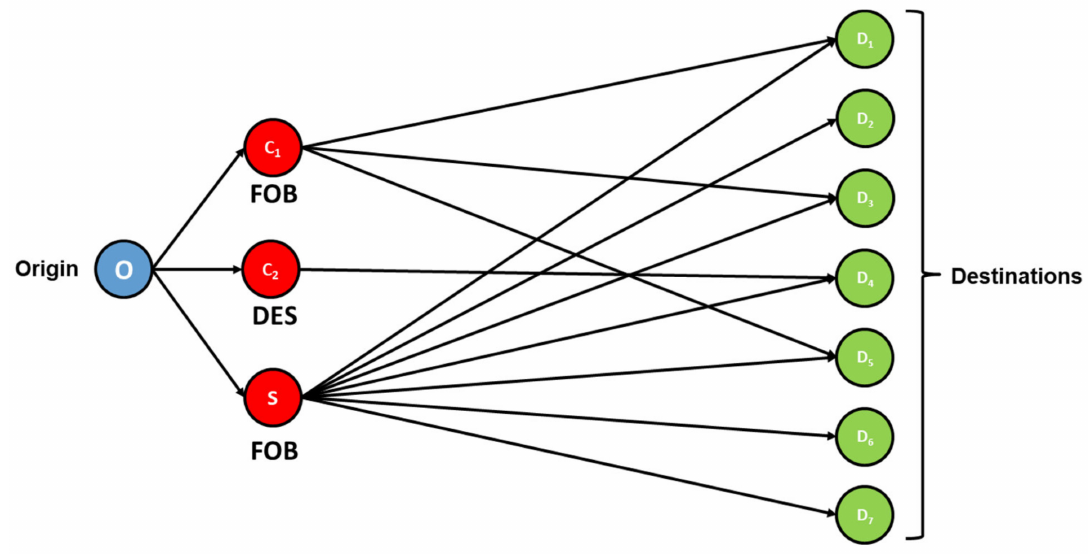
Figure 9. LNG trade across